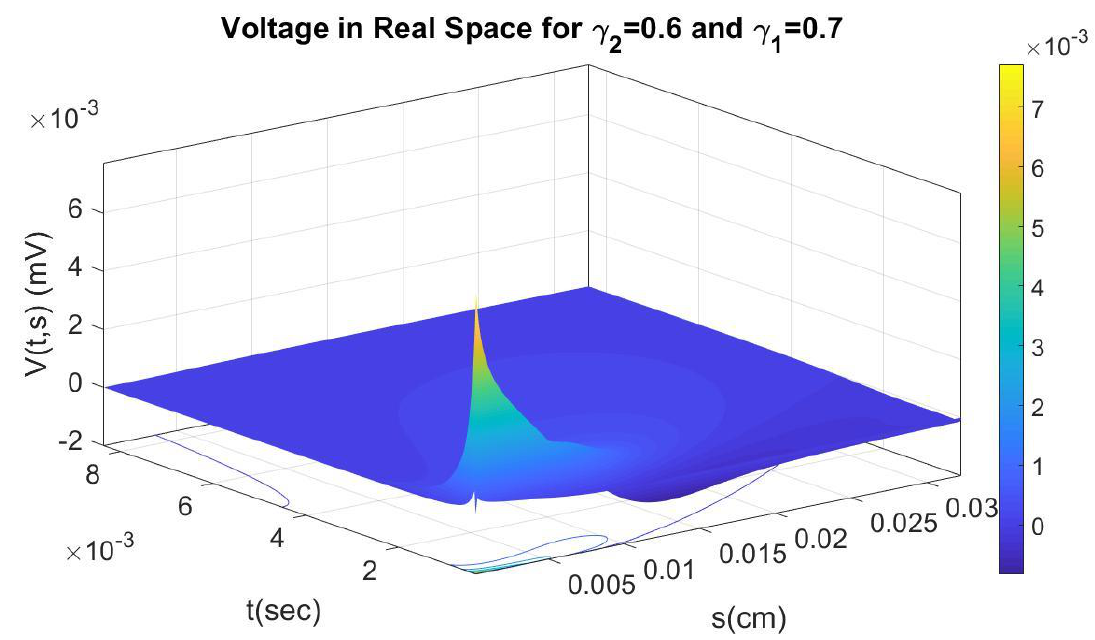
Figure 9. The voltage V(t,s) in real space as a function of time and arc length s, for fractional orders γ 2 = 0.6 and γ 1 = 0.9.